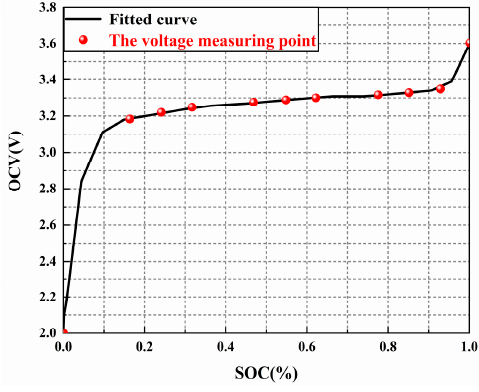
V SOC − fitting curve [22]. Figure 5. V ocv − SOC fitting curve ocv